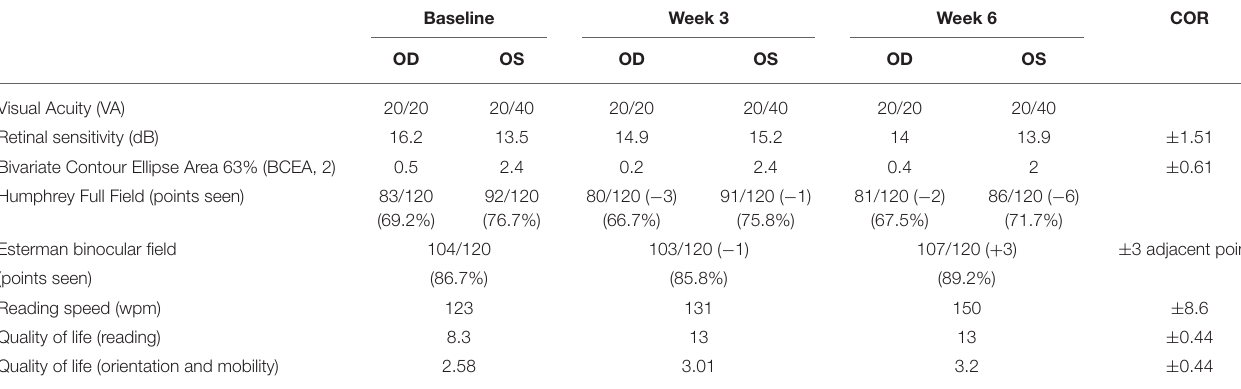
TABLE 3 | Case 2 baseline and after treatment outcome